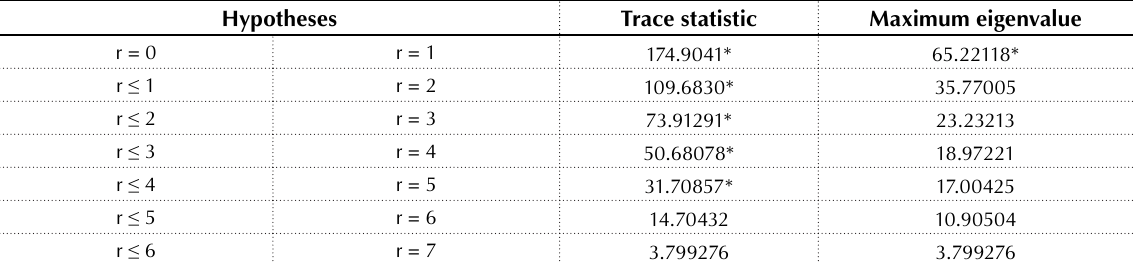
Table 2. Cointegration test